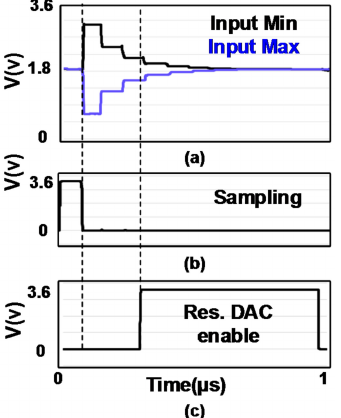
Figure 13. Simulation results for; ( a ) CDAC output settling for the maximum and minimum values of input signal; ( b ) sampling; ( c ) RDAC enable